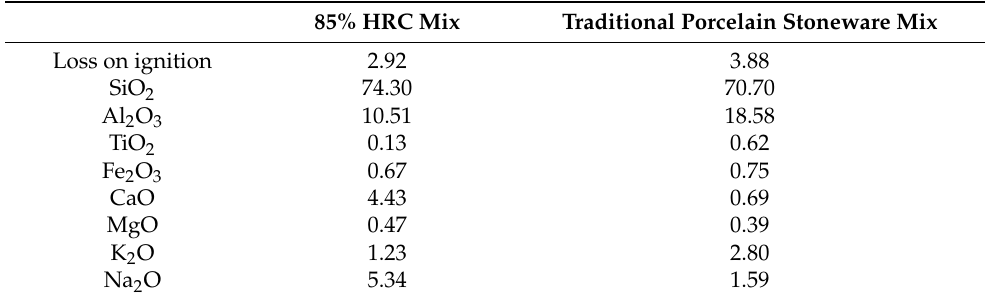
Table 1. Chemical compositions (oxides wt%) of the unfired powders of the 85% HRC mix and traditional porcelain stoneware mix.